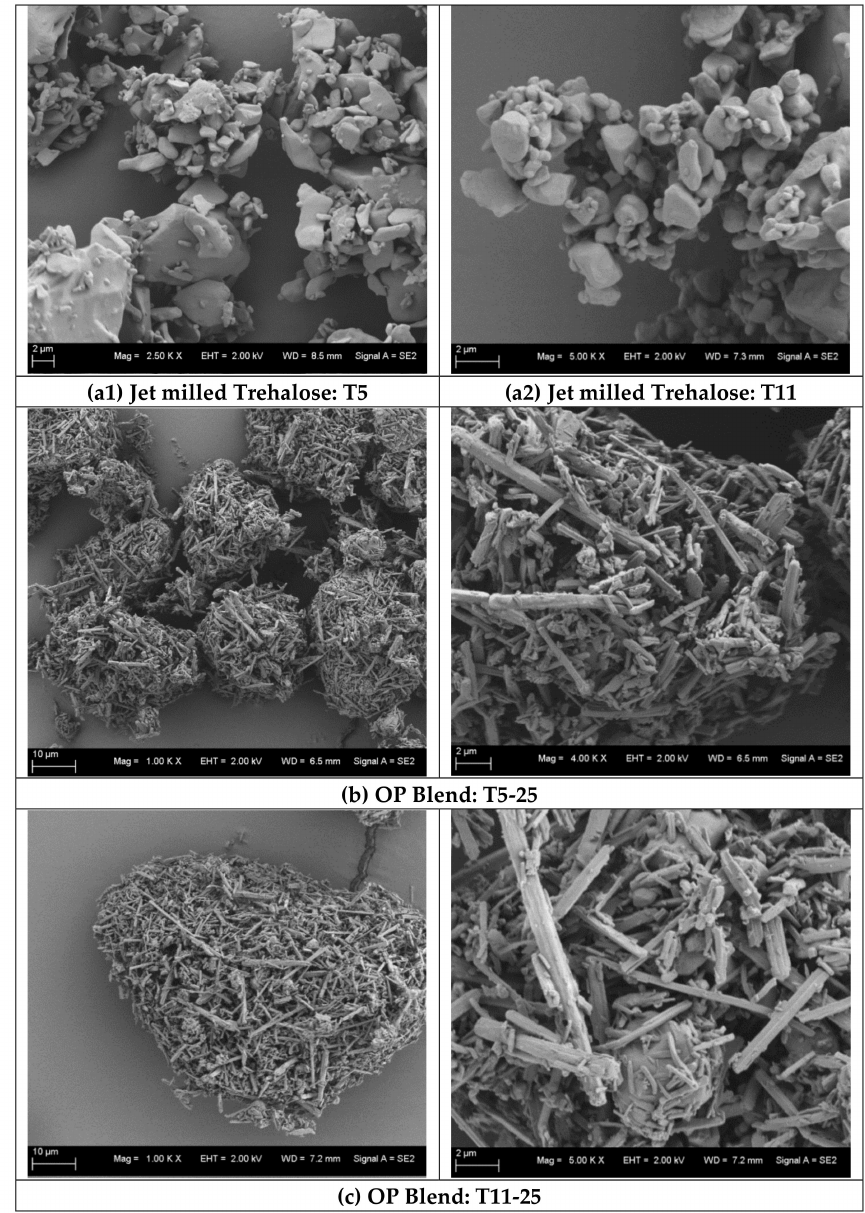
Figure 4. SEM images of ( a ) jet milled trehalose qualities ( a1 ) T5 ( × 2.5 k) and ( a2 ) T11 ( × 5.0 k), ( b ) OP / T5 blend (left: × 1.0 k and right: × 4.0 k) and ( c ) OP / T11 blend (left: × 1.0 k and right: × 5.0